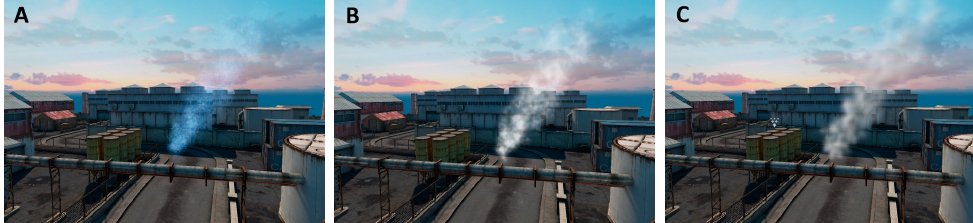
Figure 5. The same gas plume, as visualized with each of the presented methods: ( A ) billboarded 2D assets, ( B ) procedural textures from OpenSimplex noise, and ( C ) volumetric rendering through ray